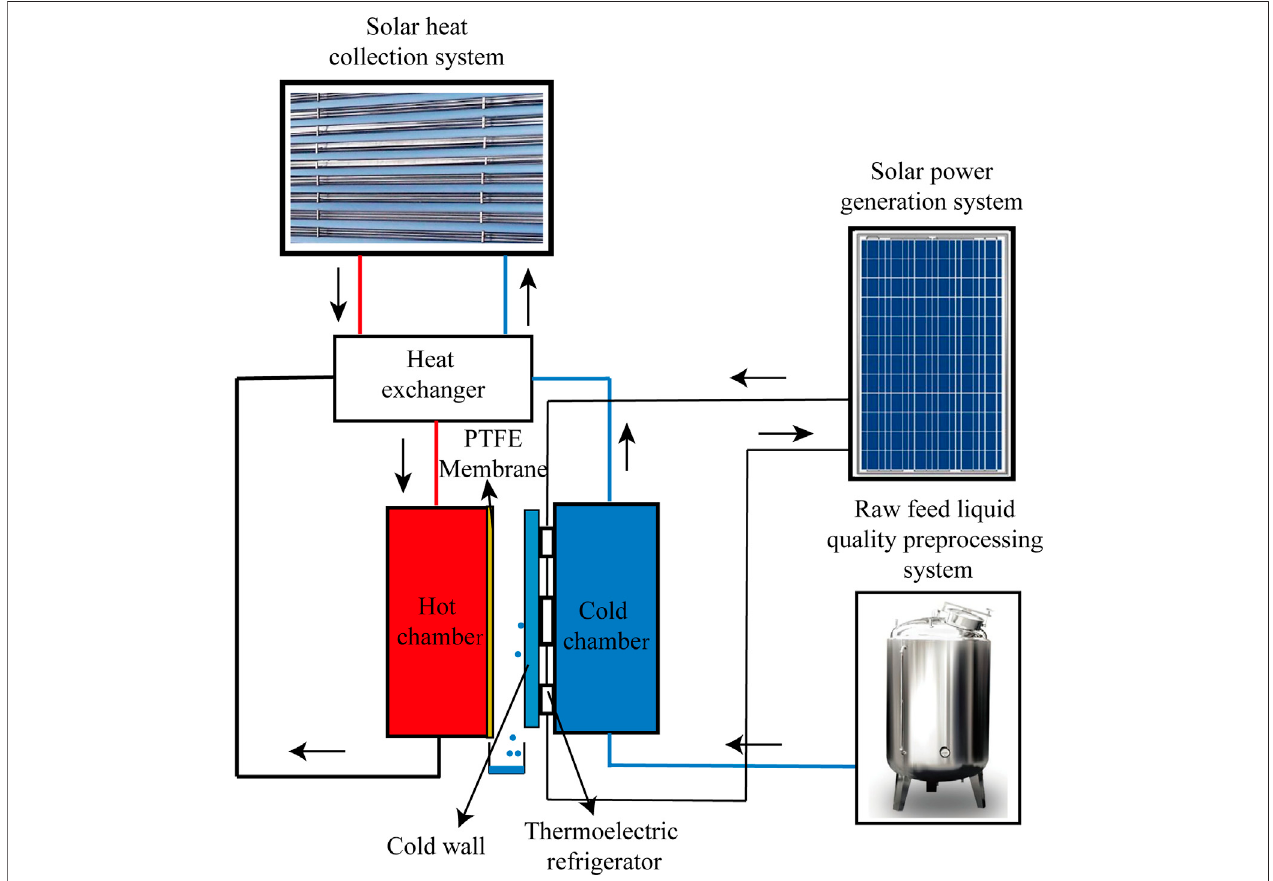
FIGURE 1 | Schematic of a thermoelectric refrigeration air gap membrane distillation system.